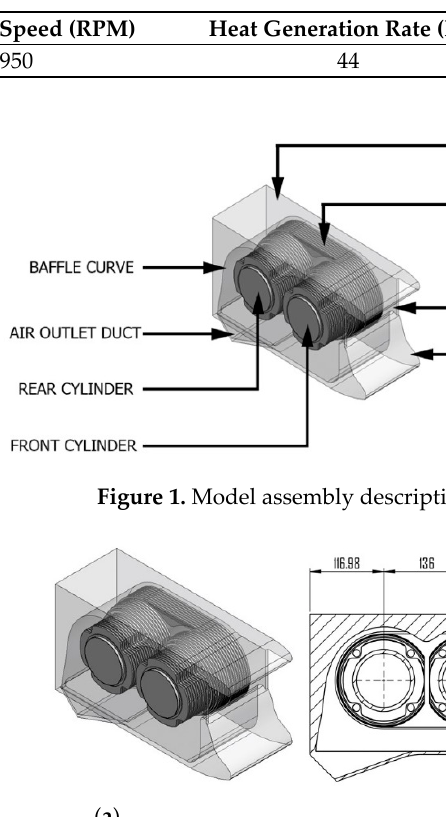
Table 4. Engine working condition at 75% power.